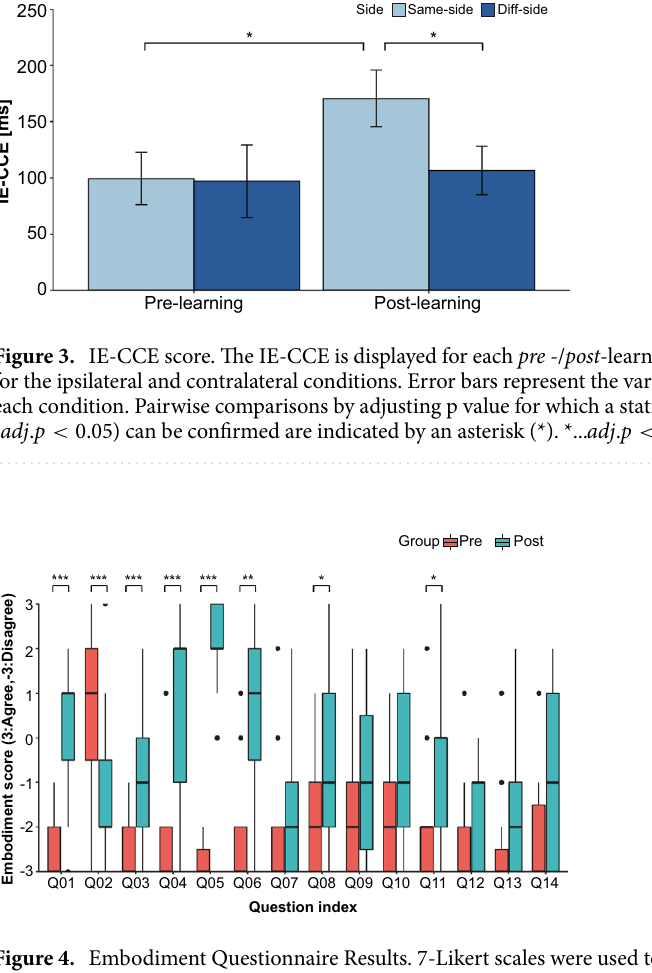
Figure 4. Embodiment Questionnaire Results. 7-Likert scales were used to collect responses to each question in each of the pre- and post- learning stages. Bar graphs are shown for each condition. The results are shown as boxplots for each condition. Asterisks (*) indicate statistically significant differences between the pre- and post- learning conditions. *... p < 0.05 , **... p < 0.01 , ***... p < 0.001